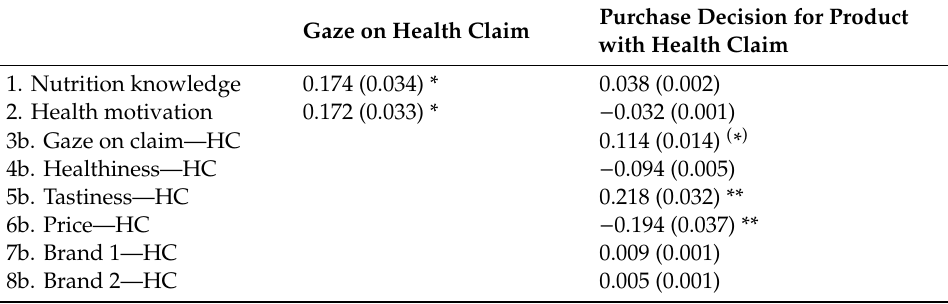
Table 9. Path coe ffi cients and their e ff ect sizes—health